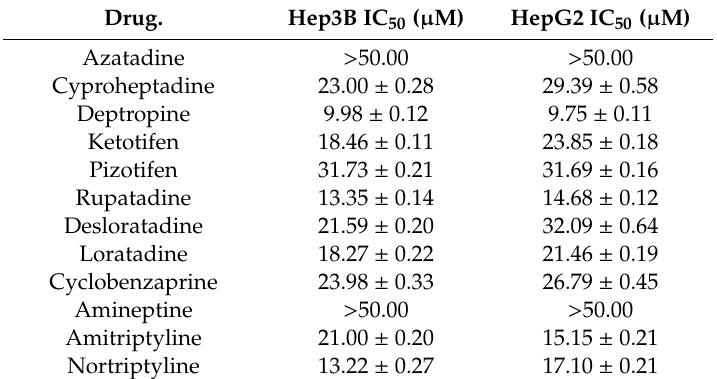
Table 1. Cytotoxic e ff ects of 12 benzocycloheptene analogous drugs toward human hepatoma cells. Drug.